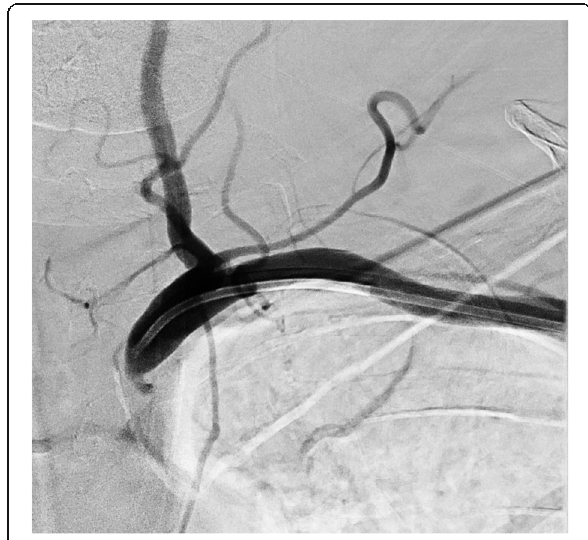
Fig. 3 Digital subtraction angiogram (DSA) of a high-grade subclavian stenosis, treated with retrograde brachial